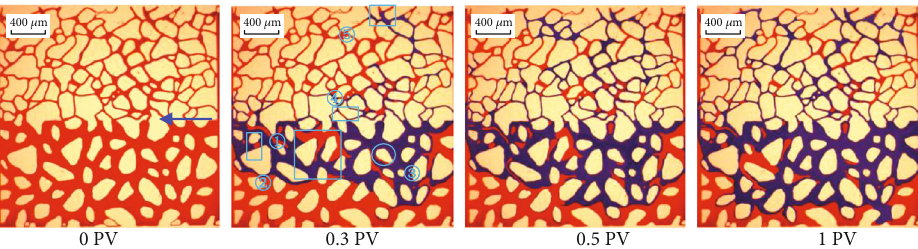
Figure 6: Distribution of residual oil under polymer surfactant fl ooding with a permeability ratio of 9 ( ① cluster, ② oil drop, ③ oil fi lm, ④ columnar, and ⑤ blind end; the red part represents oil; the blue part represents the displacement fl uid; the injection direction of the displacement agents is from right to left).